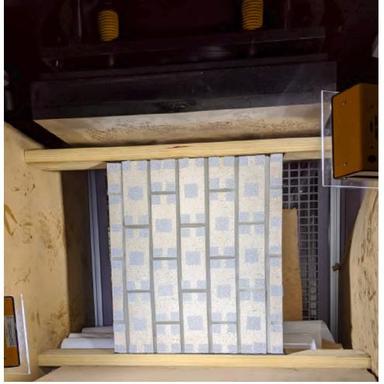
Compression test setup with direction e2 masonry specimen.